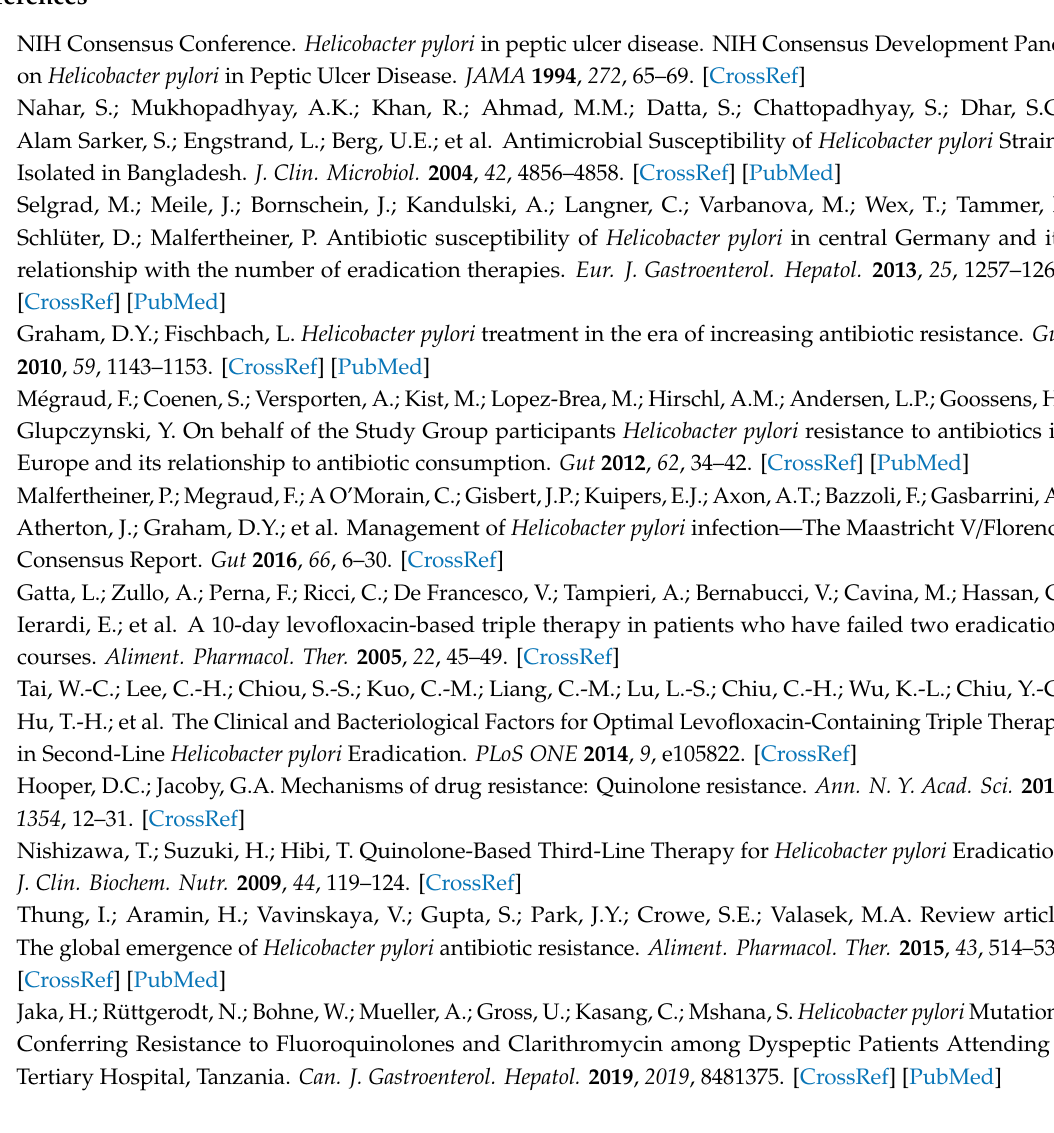
Table S1: Minimal inhibitory concentration (MIC) values and types of mutations in the QRDR of GyrA / B of 29 fluoroquinolones-resistant strains in 2005 / 2006; Table S2: MIC values and types of mutations in the QRDR of GyrA / B of 21 fluoroquinolones-resistant strains in 2017 /